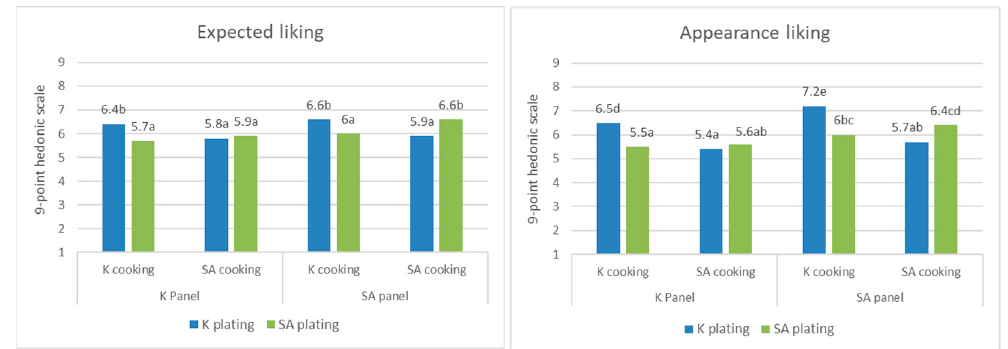
Figure 4. Effect of the nationality × cooking process × plating on expected liking and appearance liking, di ff erent letters indicate significant di ff